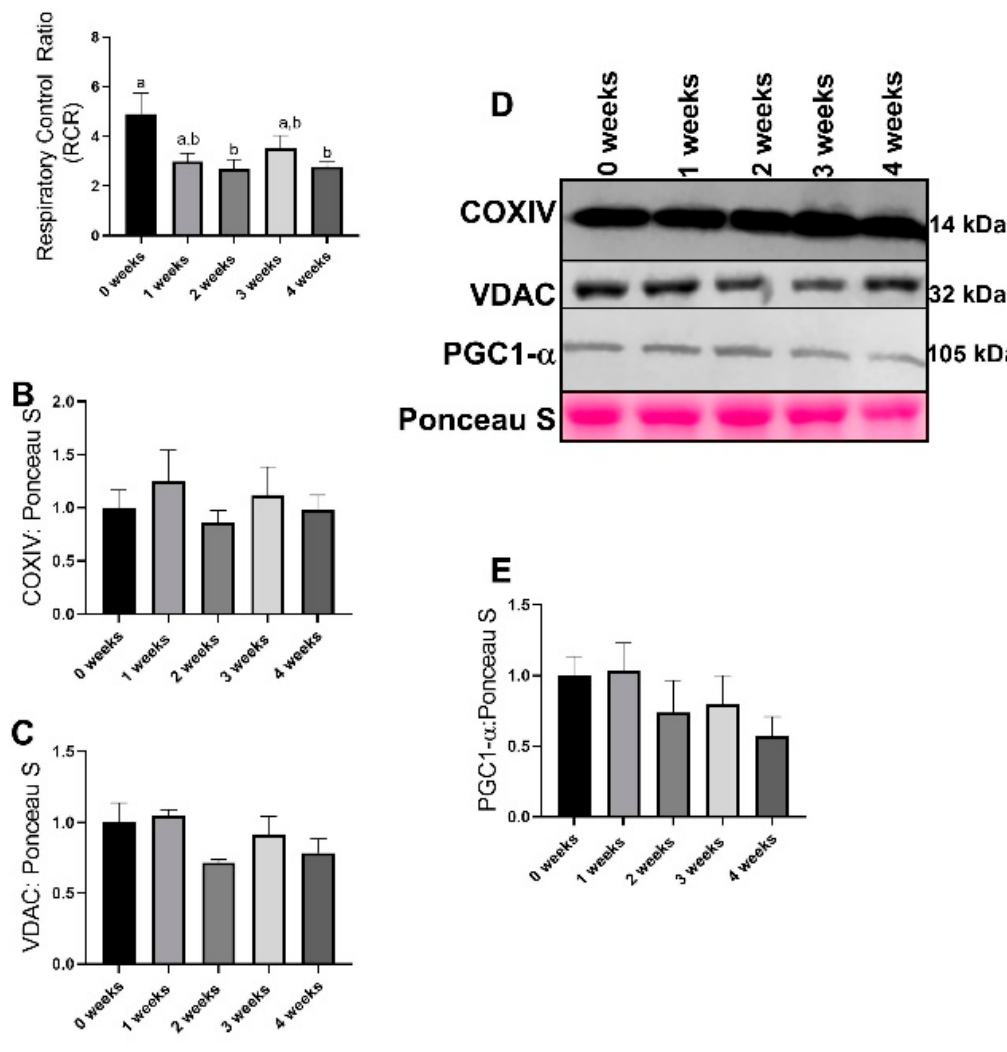
Figure 1. Mitochondrial function as related to respiratory control ratio (RCR) and markers of mitochondrial content and biogenesis. ( A ) Mitochondrial state 3: state 4 respiration, also known as respiratory control ratio (RCR). ( B ) COXIV (Mitochondrial cytochrome c oxidase subunit IV) protein content. ( C ) VDAC (Voltage-dependent anion channel) protein content. ( D ) Representative images for immunoblotting from the current study. ( E ) PGC1 α protein content. Data are presented as mean ± SEM. Different letters represent statistical differences at a Tukey adjusted p < 0.05. n = 8–10/group.